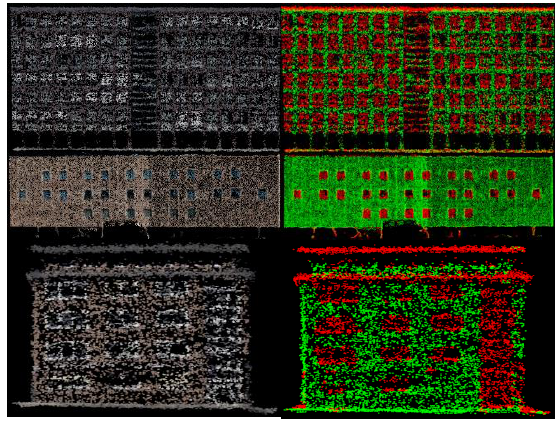
Figure 7. Left column: Point cloud from Mobile Mapping data. Right column: Segmentation into façade plane (green points) and primitives (red)